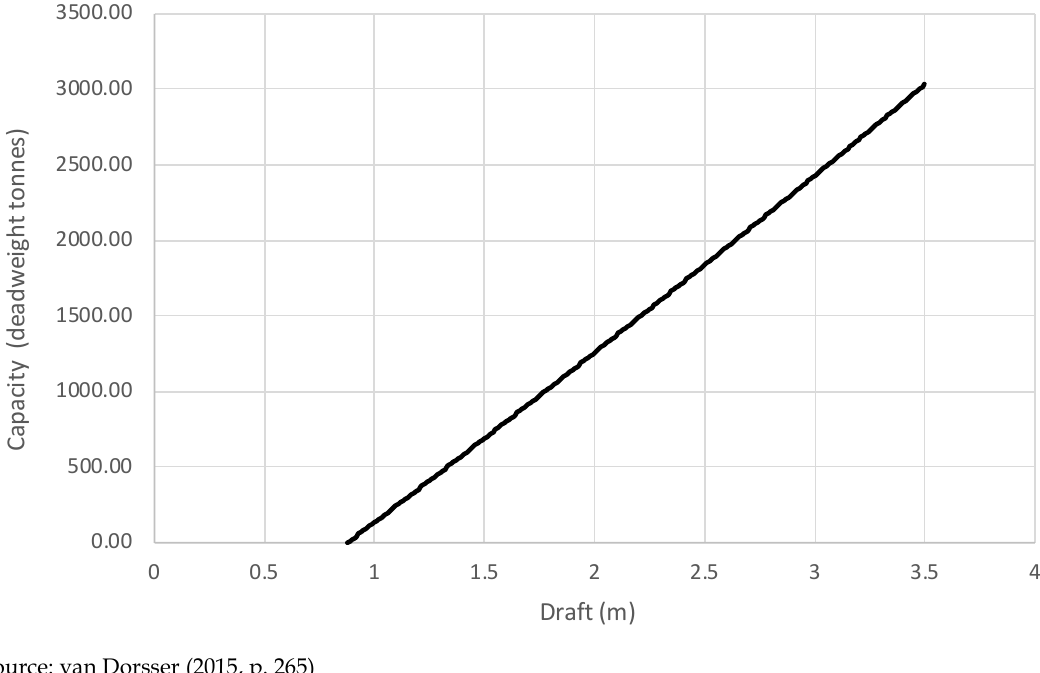
Figure 2. Typical example of a deadweight to draft relation for a 110 x 11.45 m